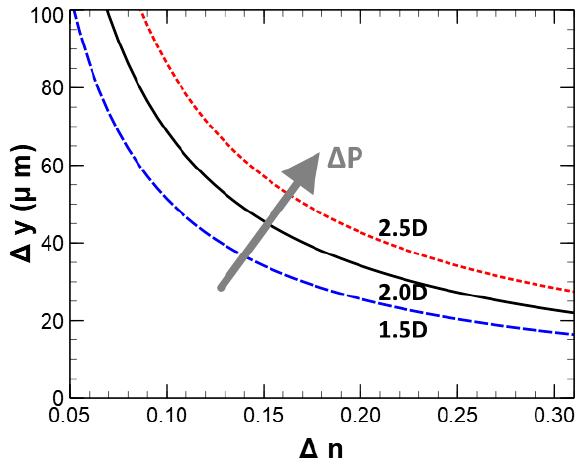
Figure 8. Plot of the maximum change in focal power with respect to the cavity spacing of the lens [38,42]. Increasing the birefringence of the LC enables a smaller gap to be used to achieve the same change in focal power.